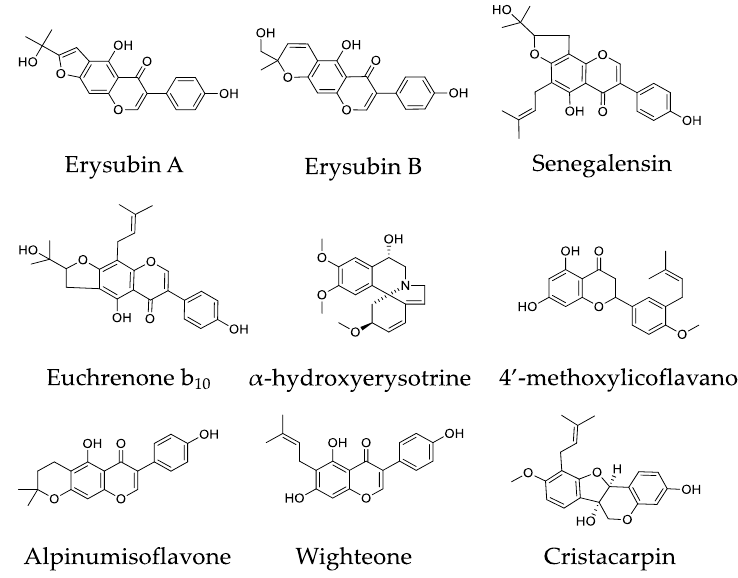
Figure 2. Chemical structures of selected compounds isolated from Erythrina suberosa